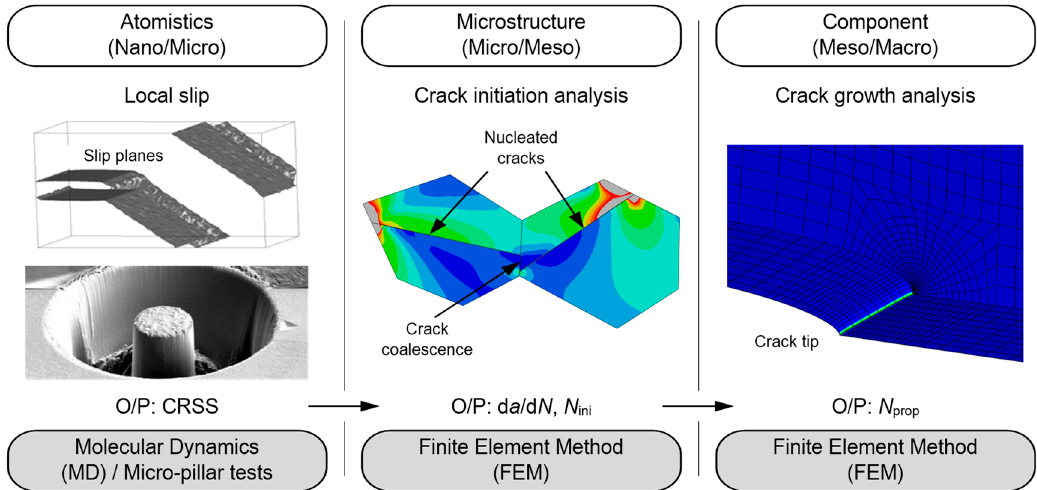
Figure 5. Multiscale approach—Coupling of methodologies at the relevant scales, and accompanying outputs (O/P) (CRSS, d a /d N —crack growth rate, N ini —number of stress cycles for crack initiation, N prop —number of stress cycles for crack propagation), reproduced from [34,45,50,53], with permissions from Elsevier, 2016 and John Wiley and Sons, 2014, 2017.